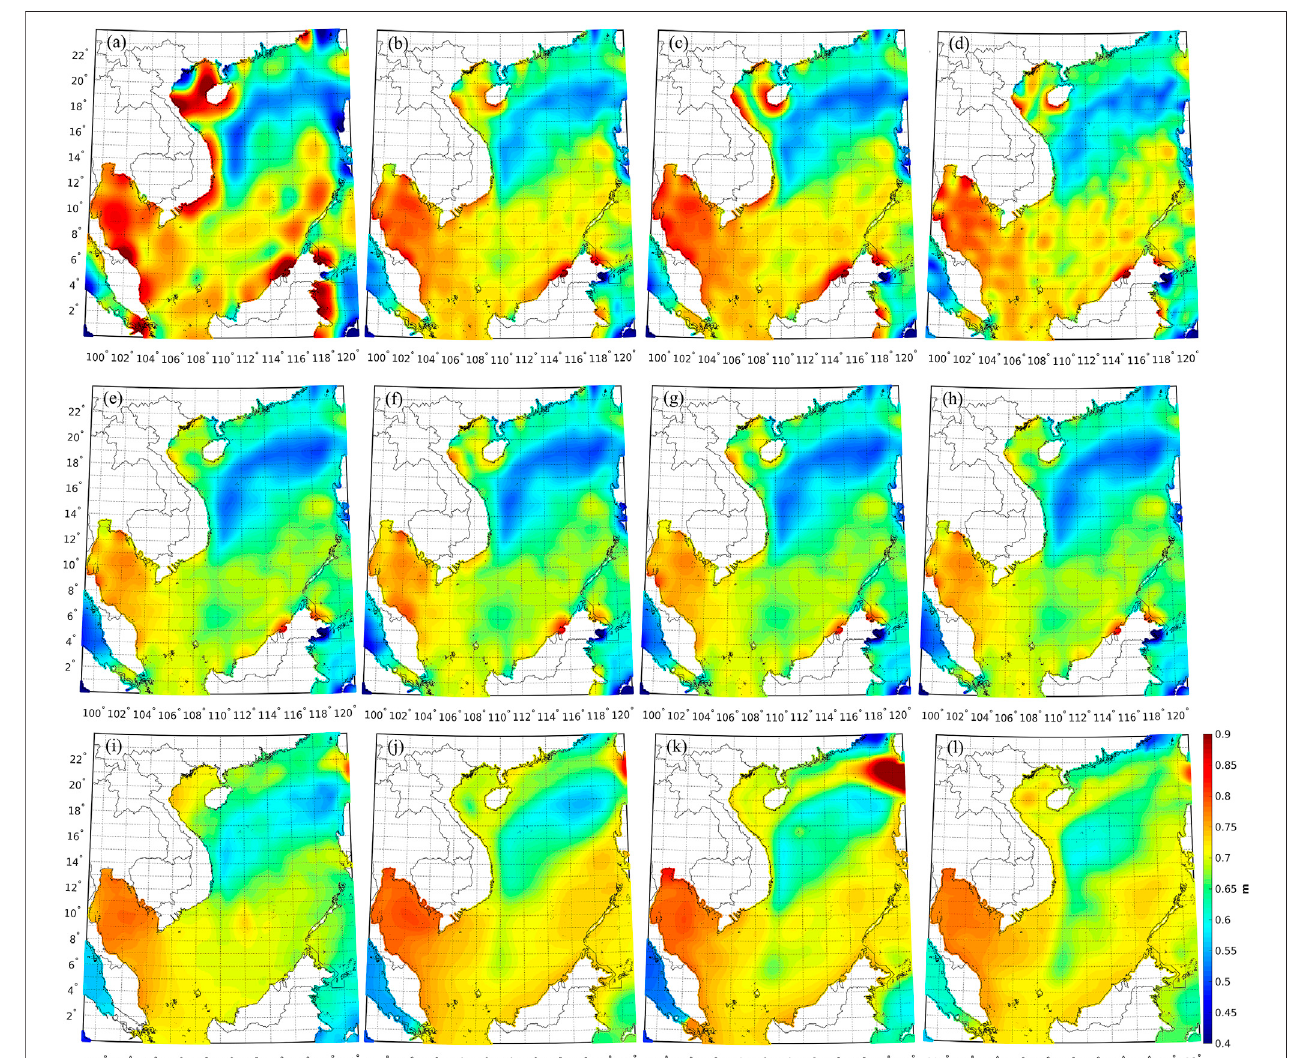
FIGURE 7 | Geodetic MDT calculated from (A) EGM2008, (B) GECO, (C) SGG-UGM-1, (D) EIGEN-6C4, (E) XGM2019_2159, (F) GOCO05c, (G) XGM2016, and (H) XGM2019; and existing synthetic/ocean models, (I) CNES-CLS13MDT, (J) SODA, (K) ORAS5, and (L) OCCAM.